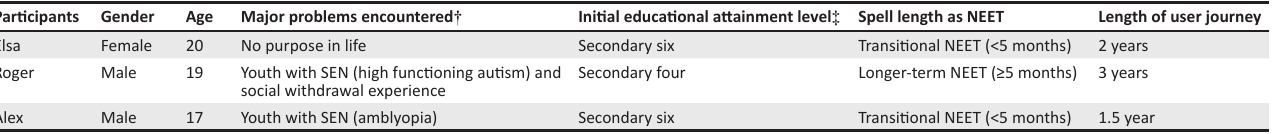
TABLE 1: Sociodemographic information of the three participants. Participants